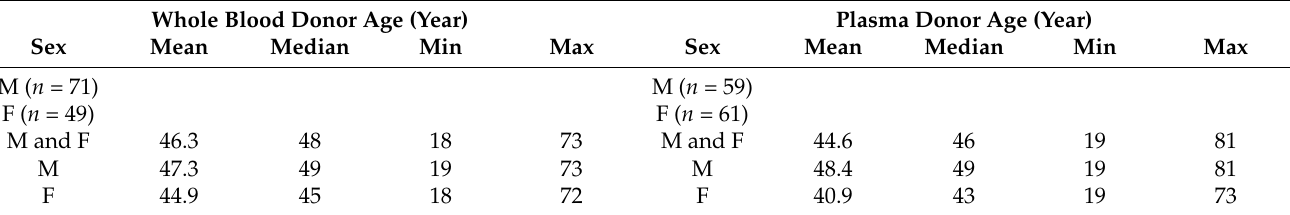
Table 1. Age and sex of blood bank